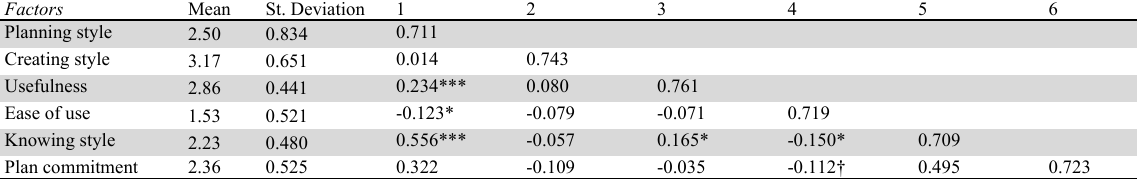
Means, standard deviations, and correlations matrix among the study construct Factors